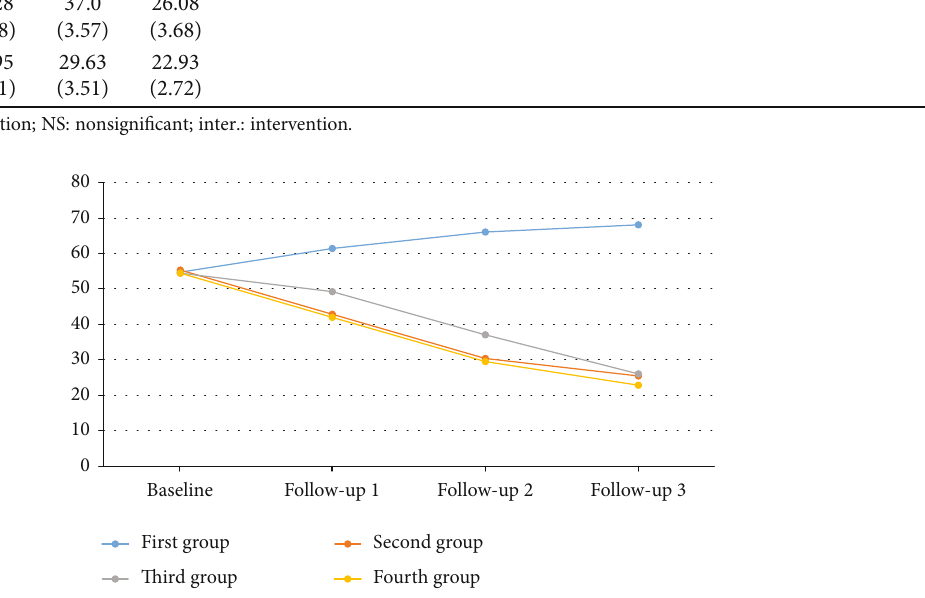
Figure 3: The trend of state anxiety from baseline up to 21-month